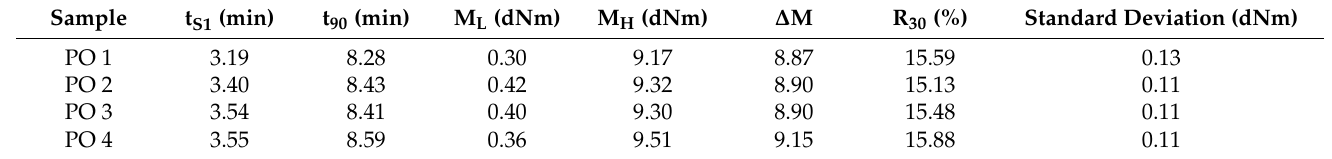
Table 6. Cure characteristics for different ratios of